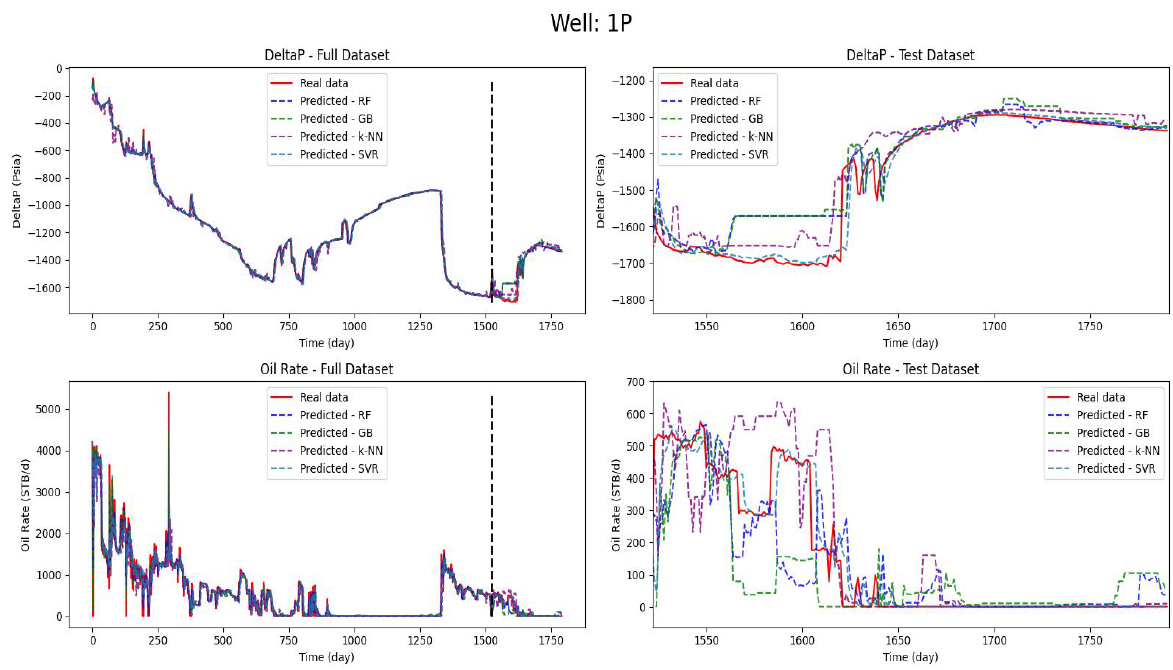
Figure 3 — Test Case 2 with Classical ML Algorithms. Dataset (Top Right); Oil Rate vs Time – Full Dataset (Bottom Left); Oil Rate vs Time – Test Dataset (Bottom